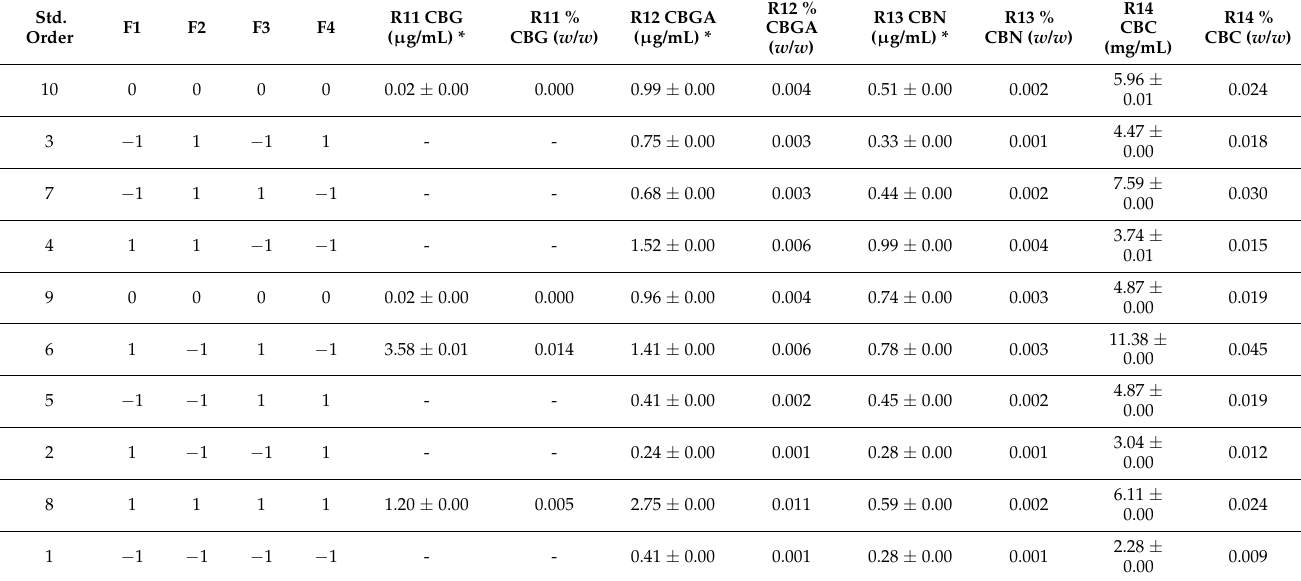
Table 8. HPLC quantification for cannabigerol (CBGA), cannabigerolic acid (CBG), cannabinol (CBN), and cannabichomere (CBC) in the supercritical carbon dioxide